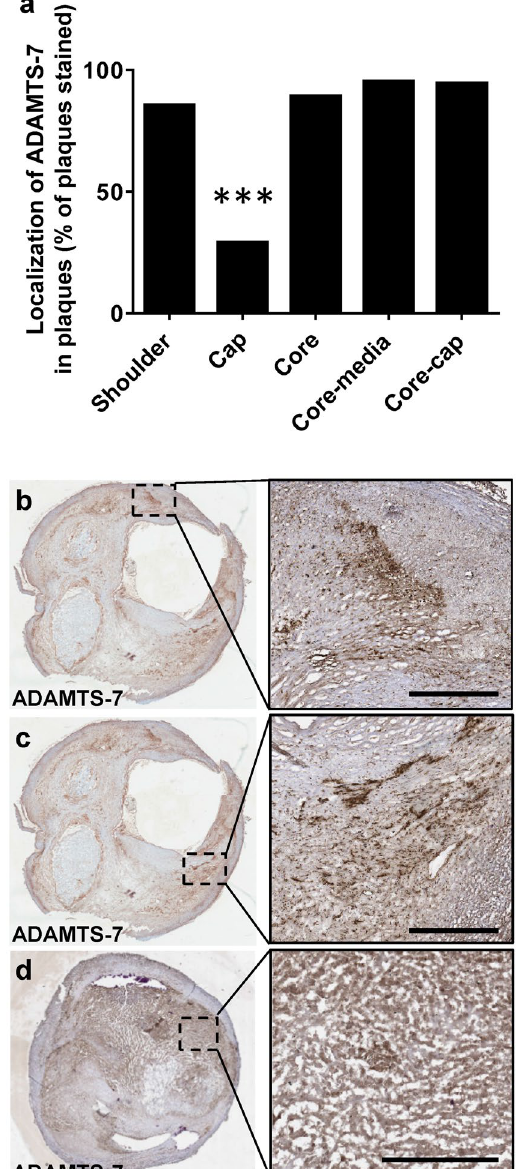
Figure 3. Localization of ADAMTS-7 in human carotid plaques. The presence of ADAMTS-7 (% of plaques stained) in different regions of the plaque were analysed ( a ). Representative images are shown for staining of ADAMTS-7 in shoulder regions ( b–c ), and in the core ( d ) of the plaques. Scale bars: 500 μ m. p < 0.0001 (cap region compared to all of the other regions); Chi-square